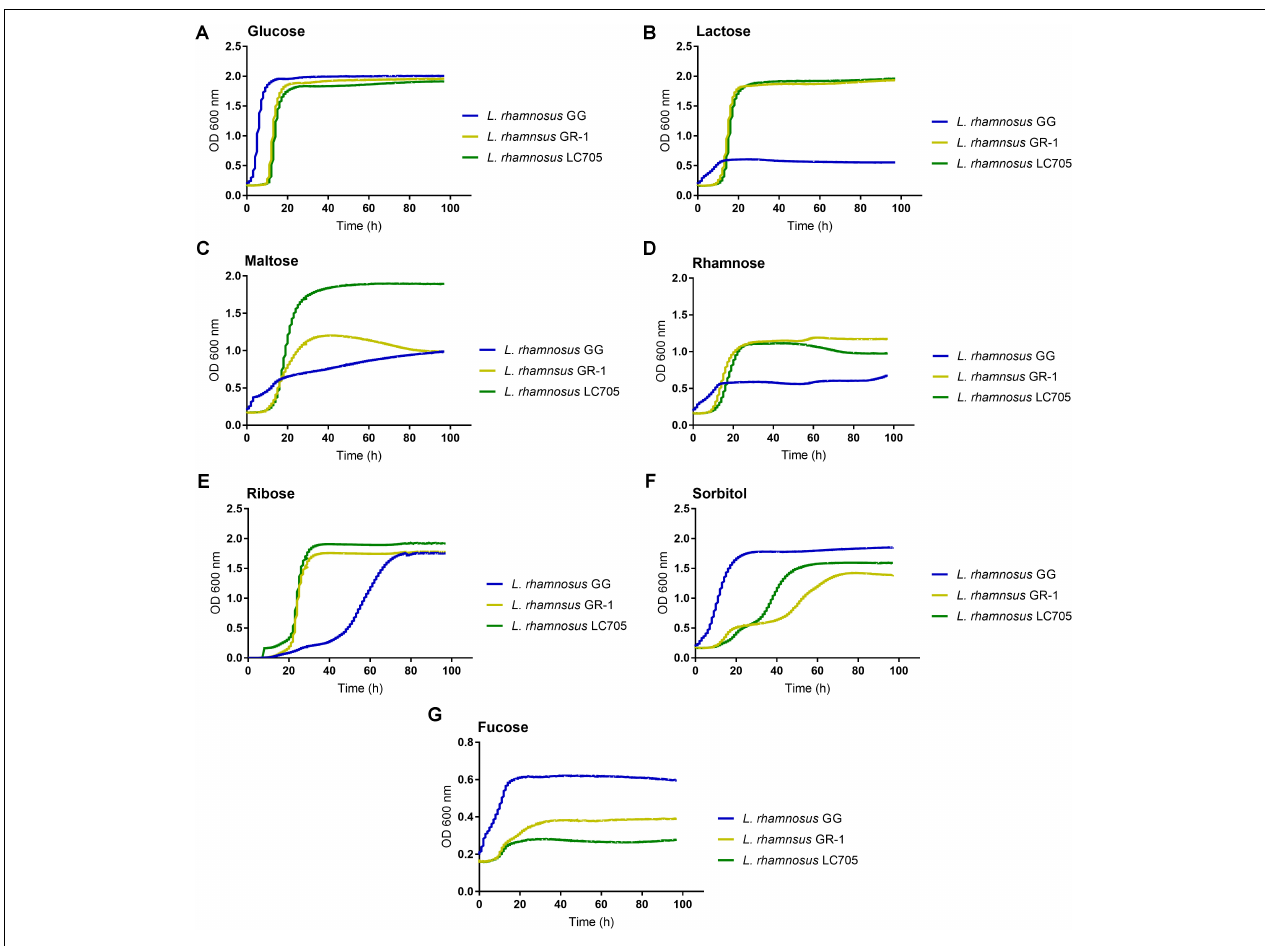
FIGURE 3 | Comparison of the metabolic capacity of L. rhamnosus GG, L. rhamnosus GR-1, and L. rhamnosus LC705. All the experiments were performed in modified MRS in which the main carbon source being glucose (A) was replaced with lactose (B) , maltose (C) , rhamnose (D) , ribose (E) , sorbitol (F) , and fucose (G)